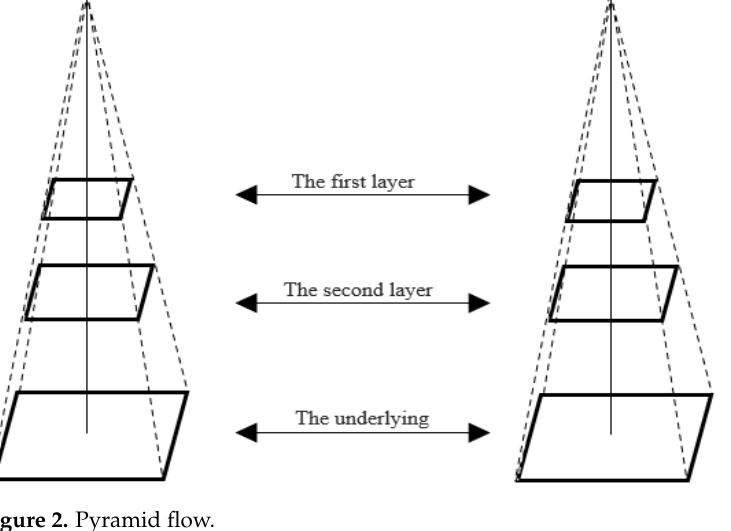
Figure 2. Pyramid Figure 2. Pyramid flow.